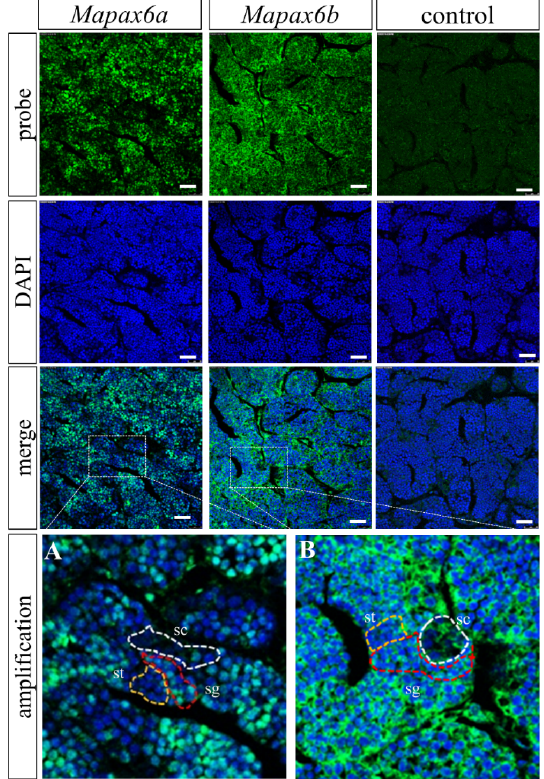
Figure 6. Distribution of Mapax6a and Mapax6b in the adult testis. The blue signal indicates DAPI staining, and the green signal exhibits the distribution of Mapax6a and Mapax6b RNA in the testis. The sense probe was used as a negative control. A and B reveal the amplification of the Mapax6a and Mapax6b signals, respectively. sc: spermatocytes, surrounded by white dotted lines; sg: spermatogonia, surrounded by red dotted lines; st: spermatids, surrounded by yellow dotted lines. Scale bars: 100 µ